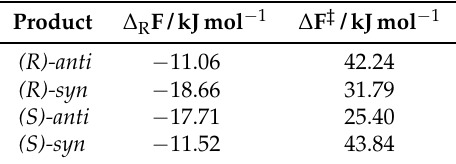
Table 4. Total reaction free energies ∆ R F and reaction free energy barriers ∆ F ‡ for the aldol reactions (R=Et) in DMF from HyAIMD metadynamics; extracted from Figure 9. Free energies are given relative to